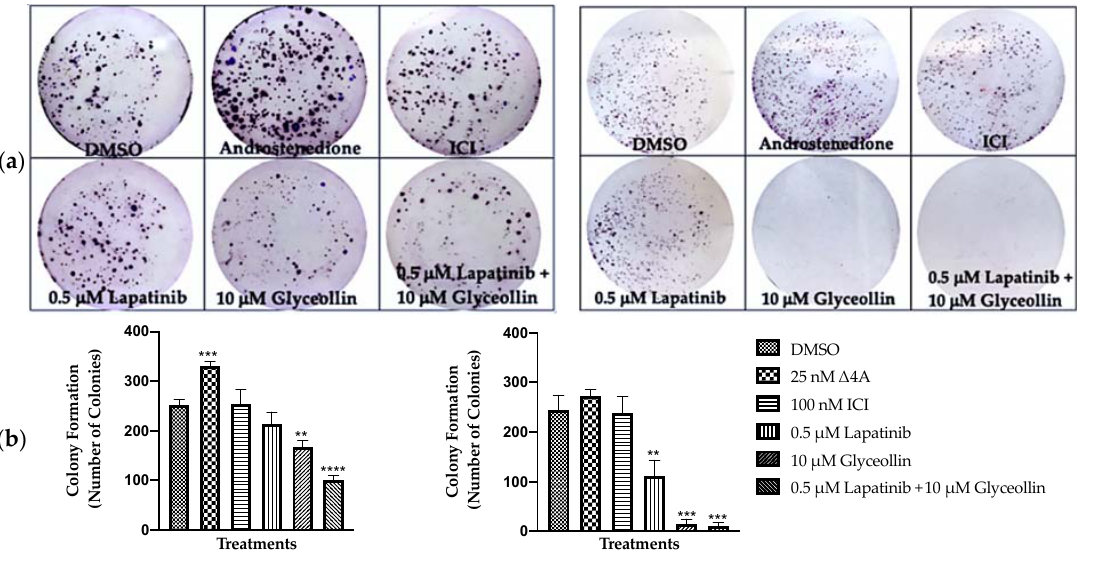
Figure 4. Glyceollin and Lapatinib dramatically inhibit the survival of letrozole ‐ resistant breast cancer cells. Colony formation assays were performed using ( a ) the T47Darom cells and ( b ) the T47DaromLR breast cancer cells. Both cell lines were cultured in standard growth media and treated for 2 weeks with DMSO vehicle control, 25 nM androstenedione, 100 nM ICI, 0.5 μ M or 1.0 μ M lapatinib, 1 μ M or 10 μ M glyceollin, 0.5 μ M lapatinib ± 1 μ M glyceollin or 10 μ M glyceollin as described in the methods section. Cells were stained using 0.5% crystal violet in 1% methanol, and graphs depict the number of cells that formed colonies after 2 weeks. Student’s t ‐ tests were performed, and treatments were compared to the DMSO control. Results are expressed as the mean unit ± SD (**** p < 0.0001, *** p < 0.001, ** p < 0.01) of three independent experiments in triplicate.